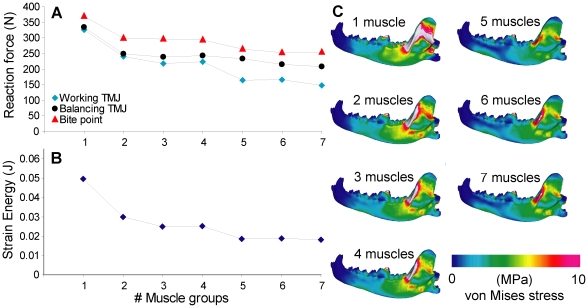
Sensitivity test on number of muscle groups.
A. Number of groups plotted against reaction force, connected by lines to show trend. B. Number of groups plotted against strain energy. C. von Mises stress distribution in the working-side dentary in test models.